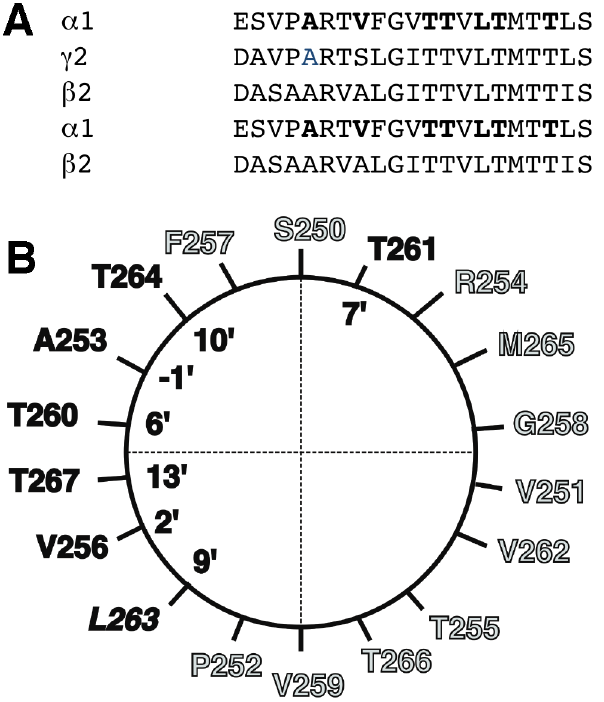
Figure 1. Aligned sequences of the amino acid residues in the subunits a 1 b 2 c 2 of the rat GABA A receptor. A, Alignment of 2 a , 2 b and 1 c subunit contributing to the formation of a GABA A pentamer. The residues in the a 1 subunit of the GABA A mutated to Cys are shown in boldface letters. B, a -Helical wheel representation of the rat a 1 M2 membrane-spanning domain showing the mutated residues in boldface letters.